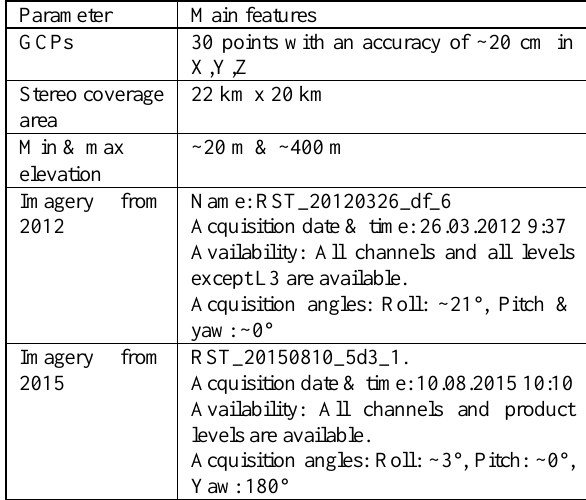
Table 3. The main characteristics of Kesan testfield.